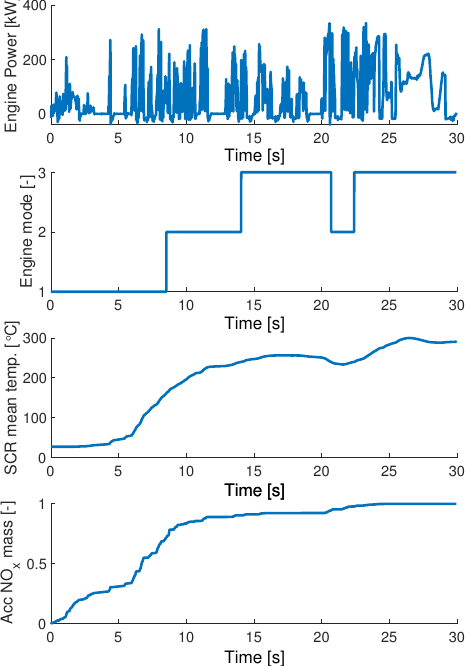
Figure 4. The baseline thermal management strategy applied to the WHTC. The behavior is very typical for the strategy: first, the least efficient mode (mode 1) is used until the front of the catalyst is hot enough, and after that, the middle mode is used until the mean temperature of the catalyst is hot enough. The middle mode is also used again after some time when the SCR becomes too